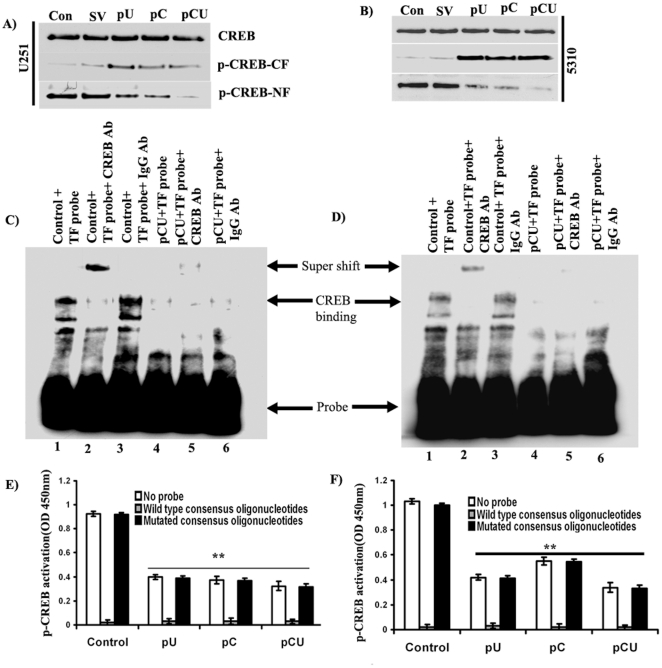
uPAR and cathepsin B downregulation retards nuclear translocation and decreases DNA binding activity of CREB.U251 and 5301 cells were transfected with SV, pU, pC or pCU for 72 hrs. Cell lysates were separated into nuclear (NF) and cytoplasmic fractions (CF) and immunoblotted for p-CREB. Total cell lysates were probed for CREB. (A–B) Western blot analysis of p-CREB in nuclear and cytoplasmic fractions of U251 and 5310 cells. Nuclear extracts were prepared from SV- (control) and pCU-transfected U251 and 5310 cells and supershift analysis of CREB binding activity was carried out using EMSA. For supershift analysis, nuclear extracts were incubated with supershift specific CREB antibody (2.0 µg) or IgG (2.0 µg) prior to incubation with CREB binding buffer. (C–D) Supershift analysis of CREB DNA binding activity in U251 and 5310 cells. The experiments were performed three times and representative blots are shown. Nuclear extracts were prepared from SV-, pU-, pC- and pCU-transfected U251 and 5310 cells, and DNA binding activity of CREB was determined by colorimetric assay using the TransAM ELISA kit. To test specificity, DNA binding activity was tested in the presence of an excess of oligonucleotide containing a wild-type or mutated CREB consensus binding site. (E–F) Inhibition of DNA binding activity of CREB by nuclear extracts of pU-, pC- and pCU-treated U251 and 5310 cells. The bars represent the mean ± SD of three different experiments. *Statistically different compared to controls and pU-, pU- and pCU-treated groups (**p<0.001).